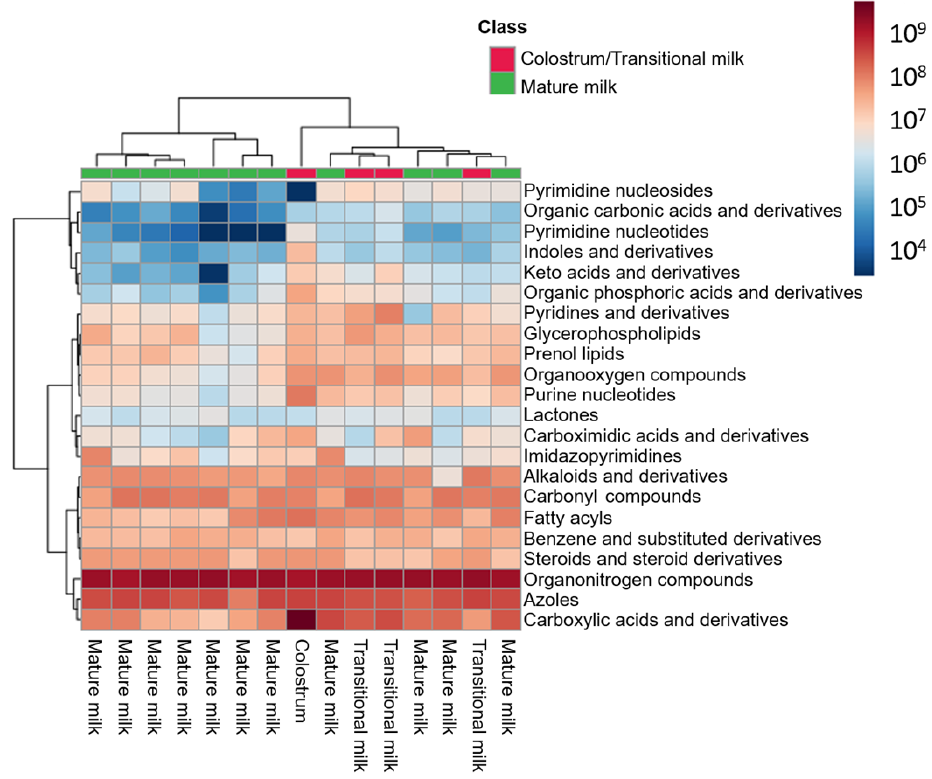
Figure 4. Heatmap of metabolite abundance grouped by metabolite class in HM